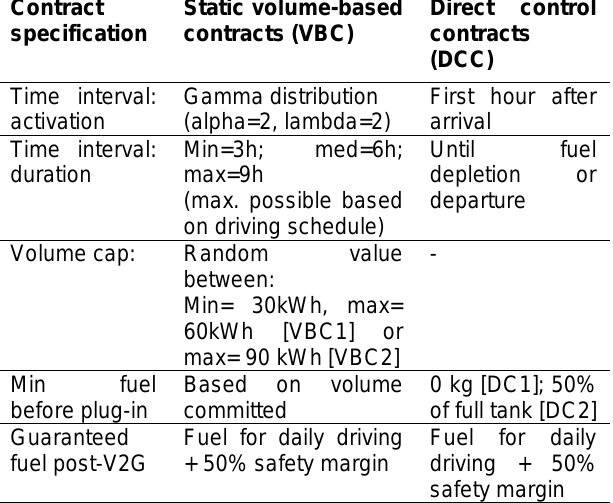
Table B.1. Initialization of contract specifications in